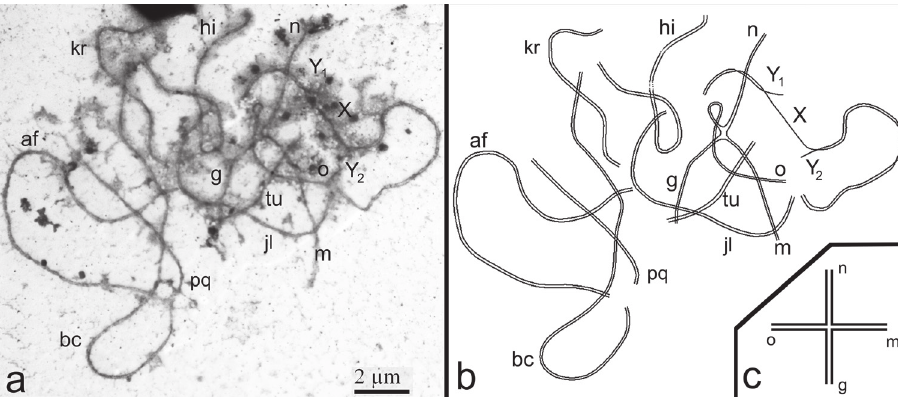
Figure 2. a–d A pachytene spermatocyte of the Moscow-Neroosa hybrid. a An electron micrograph. Seven SC bivalents ( af , bc , jl , hi , kr , pq , tu ), the sex trivalent XY detected. Closed SC tetravalent is composed of four monobrachial homologous metacentrics go , on , nm , mg . SC tetravalent is associated with two autosomes and sex trivalent. Bar = 2 μm b A scheme of chromo- some synapsis on the basis of Fig. 2a c A scheme of SC